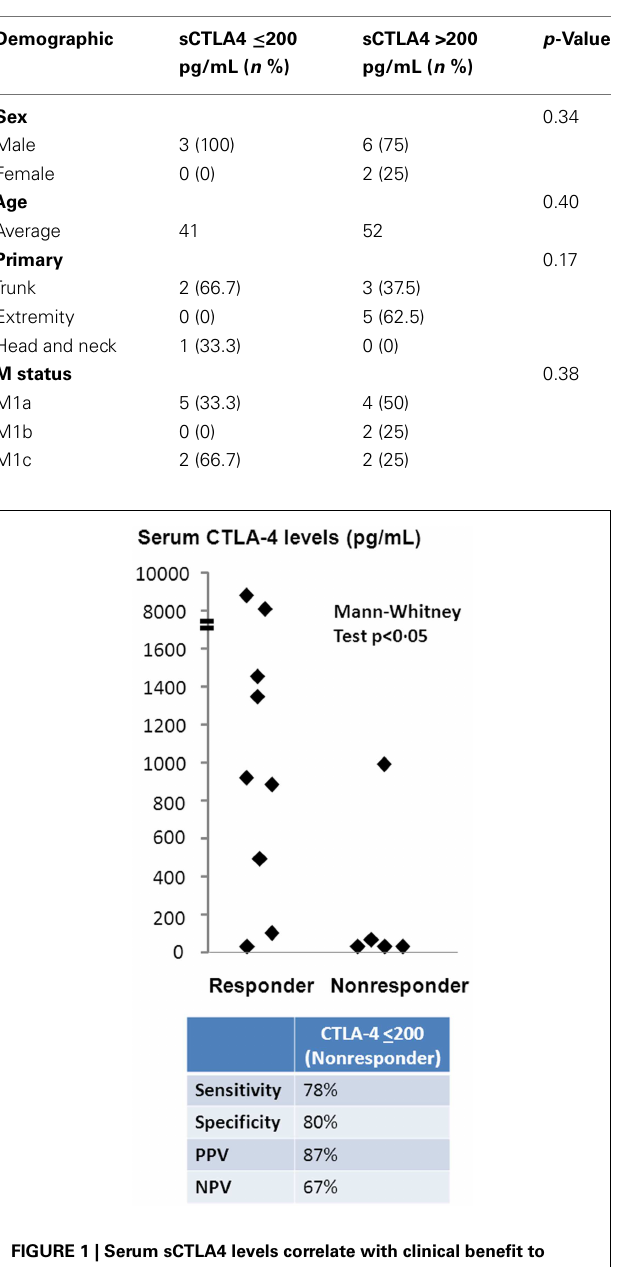
Table 3 | Univariable Cox Proportional hazard regression analysis of